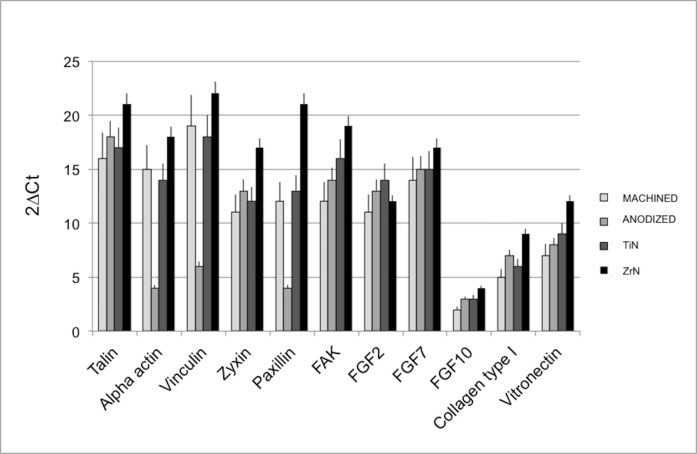
Real-time PCR analysis.Real-time PCR analysis of cell adhesion and proliferation markers in HGFs cultured on Ti disks for 21 days. Results for each experiment are obtained from triplicate experiments and values are expressed as the mean ± SD.